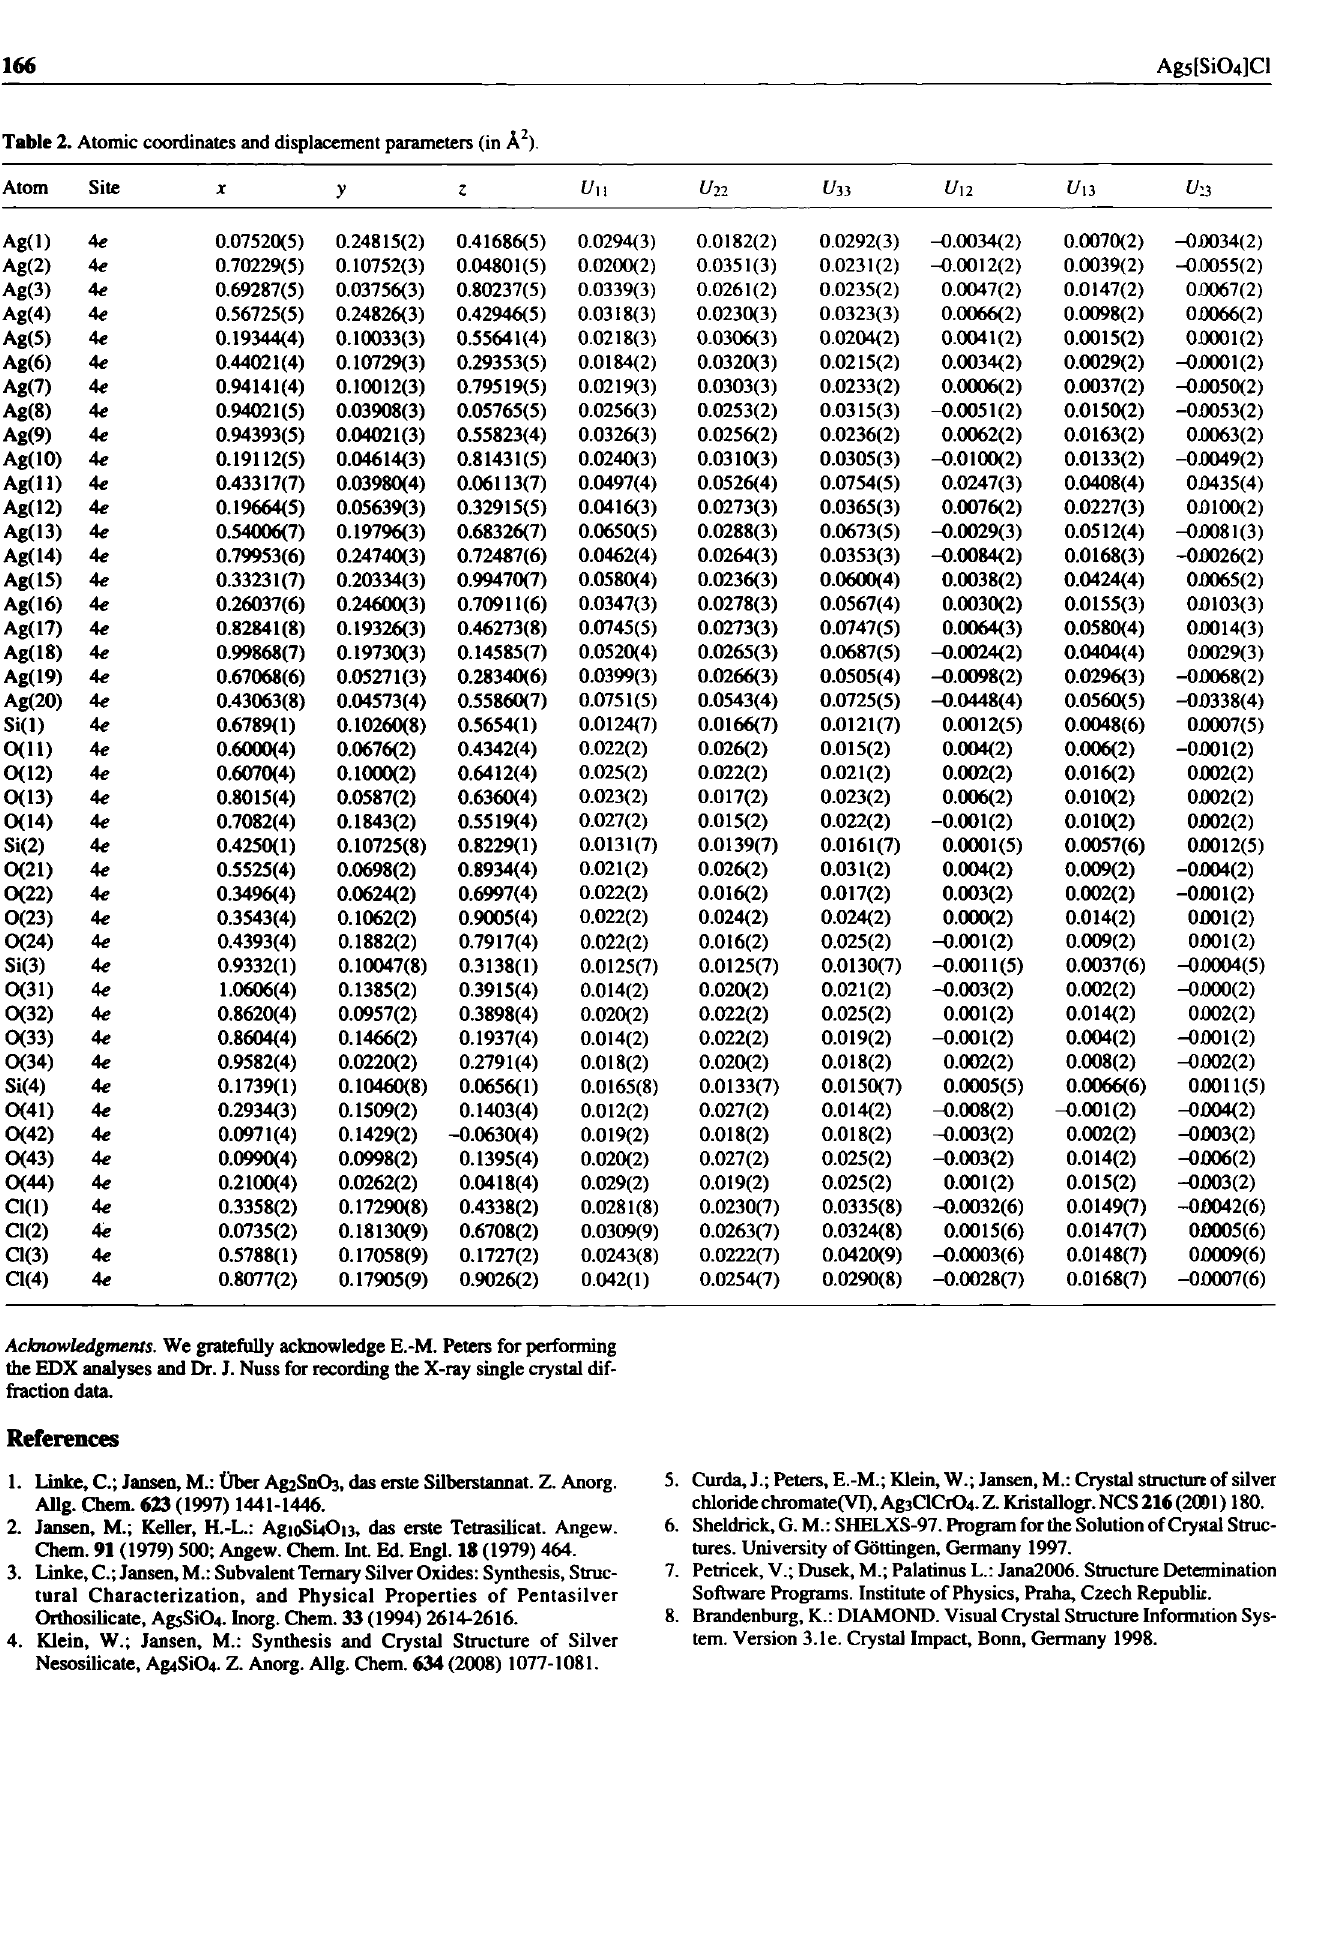
Table 2. Atomic coordinates and displacement parameters (in Â 2